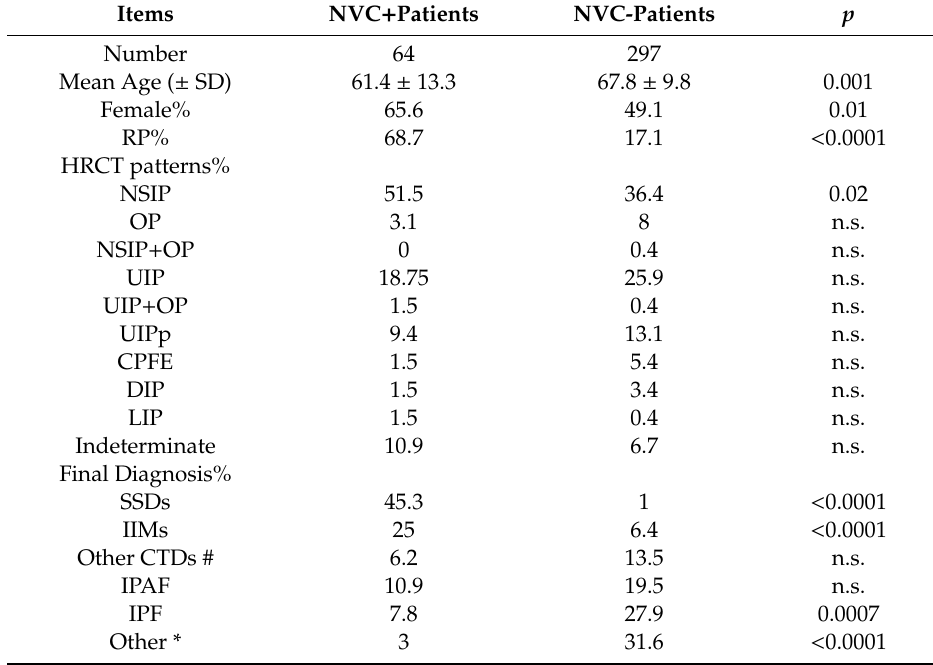
Table 2. Comparison between ILD patients with and without NVC positivity.